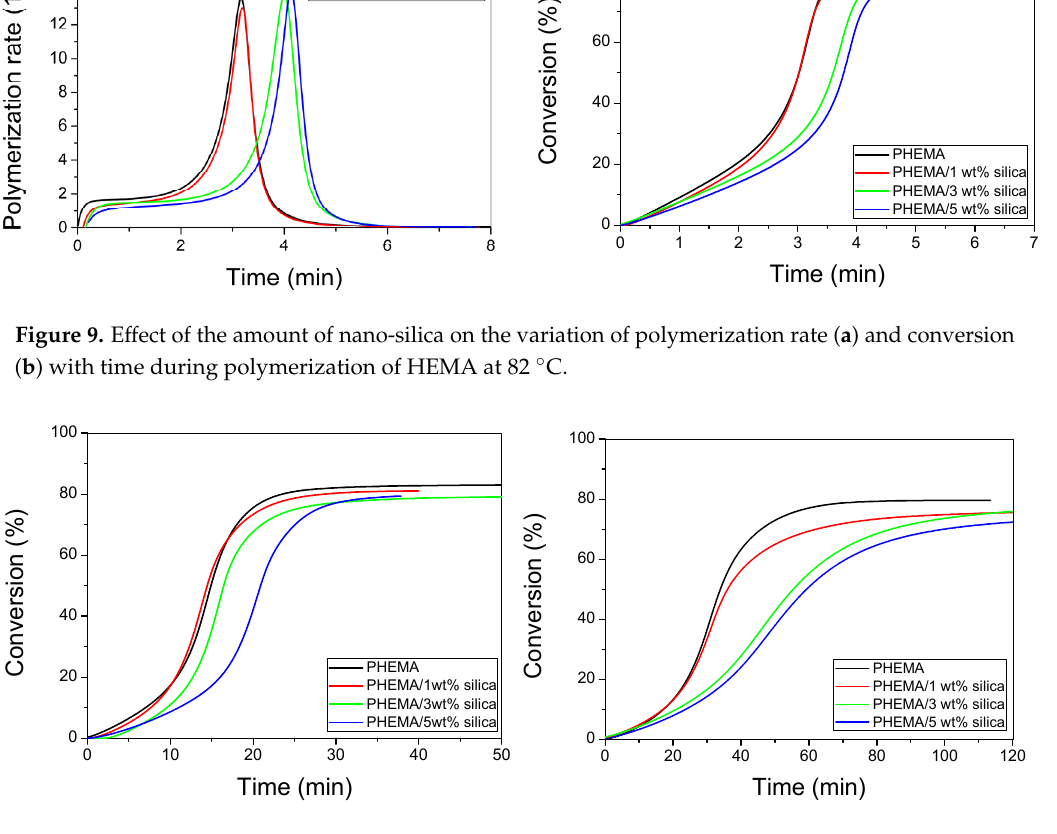
Figure 10. Effect of the amount of nano-silica on the variation of conversion with time during polymerization of HEMA at 60 ( a ) and 52 °C ( b ).